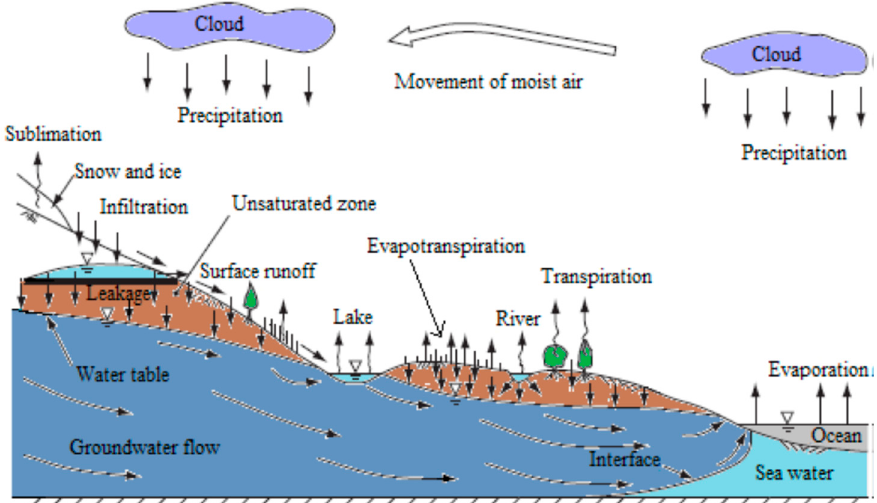
Figure 1. The hydrological cycle.